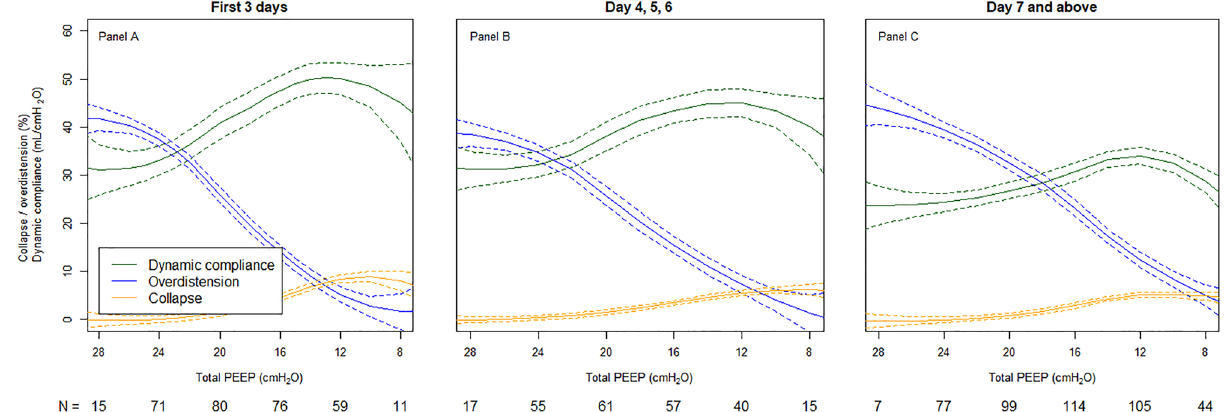
Figure 3. Dynamic respiratory system compliance, alveolar overdistension, and alveolar collapse for the whole population from admission to beyond a week after. EIT population curves that show mean (solid lines), dynamic compliance (green), overdistension (blue), and collapse (yellow) with 95% confidence intervals (dashed lines) for the whole population from PEEP steps 28 to 8 cmH 2 O over time for the first 3 days ( A ), day 4, 5 and 6 ( B ) and day 7 and above ( C ).